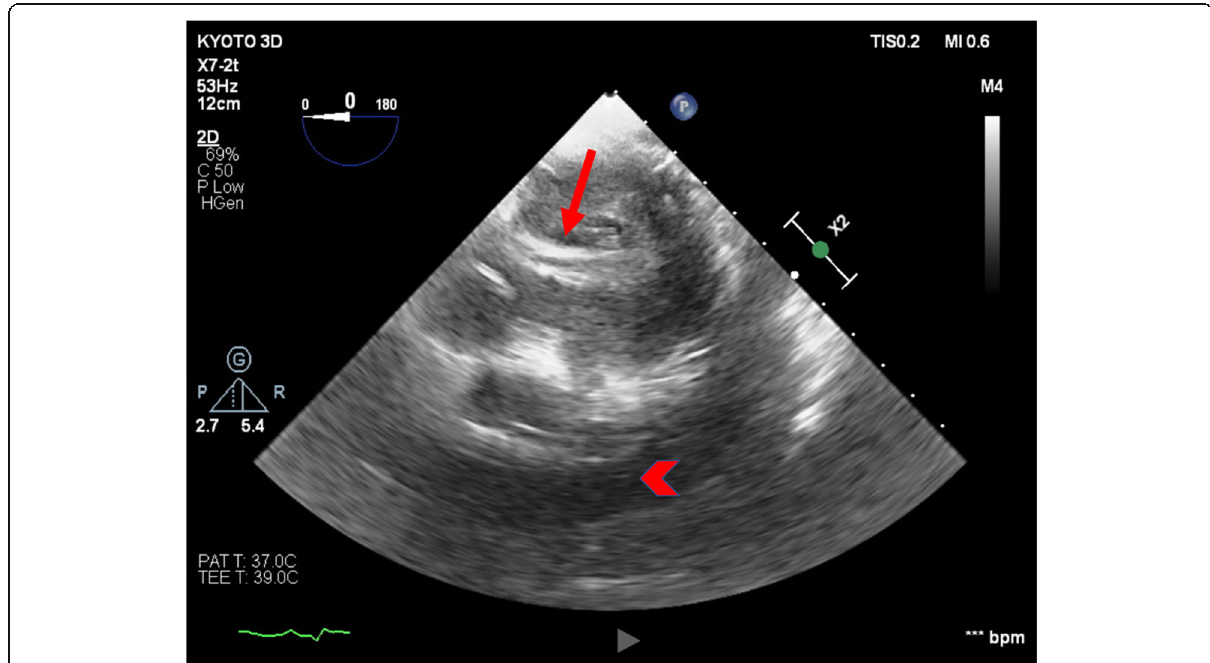
Fig. 2 Transgastric apical short-axis view by transesophageal echocardiography. Note the massive pericardial effusion (arrow head) and, the part of the IMPELLA® (small arrow)